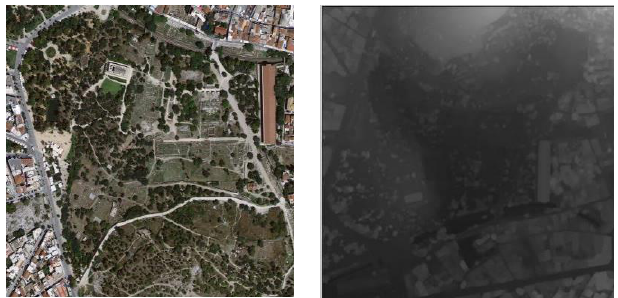
Figure 2: Orthoimage of Ancient Agora (left) and its raster DSM